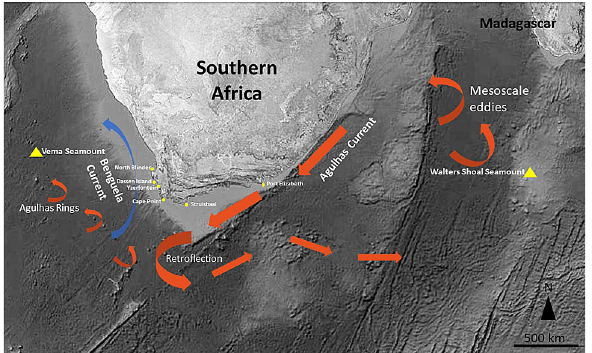
Figure 1. Map of southern Africa. The two shallow seamounts, Vema and Walters Shoal are indicated as yellow triangles, the South Africa sampling sites are indicated as yellow dots. Currents are schematised in form of arrows (red for warm, blue for cold currents). Background map created ex-novo by Dr Lauren Williams, Department of Environment, Forestry and Fisheries (DEFF), Oceans and Coasts Research, GIS Unit. Software ArcGIS version 10.3.1, licenced to